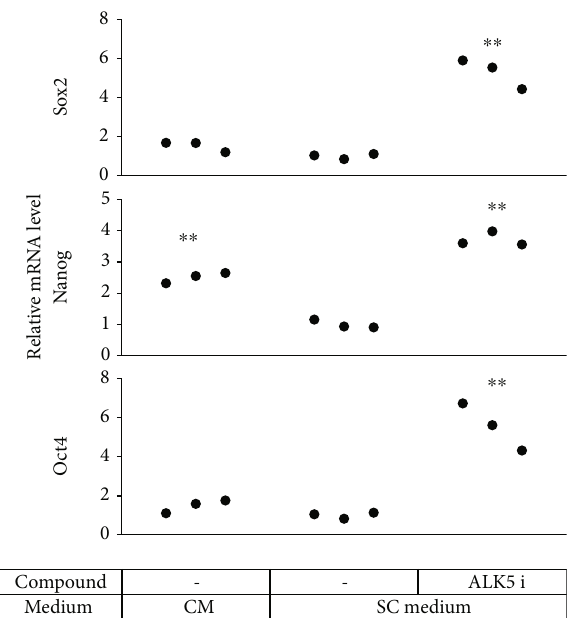
Figure 6: Impact of ALK5 i II on pluripotency-related gene expression in mSCLCs. ADSCs were cultured in a SC medium with ALK5 i II as in Figure 2. RNA was extracted from the cells 3 days after medium replacement (Figure S1) and subjected to real- time RT-PCR to evaluate mRNA levels for the indicated genes. Each dot represents a triplicate value of the relative mRNA level. ∗∗ p < 0 : 01 vs. ADSCs cultured in the SC medium